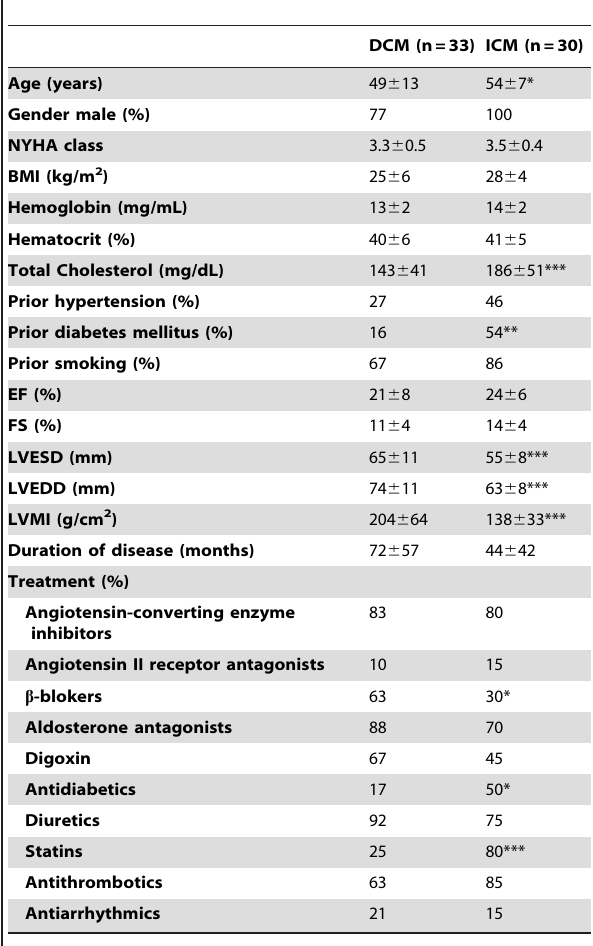
Table 1. Clinical characteristics of HF